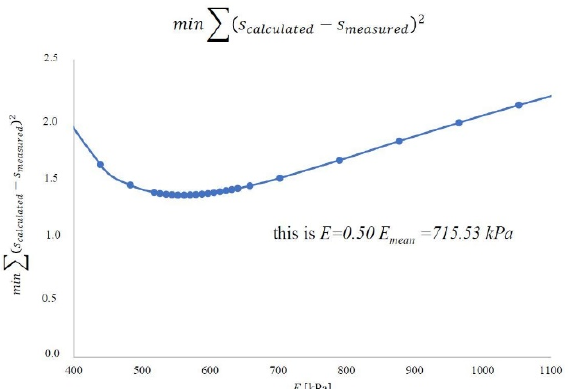
Figure 24. The representative value of the constrained modulus of elasticity of the peat material on the Ostrów Brdowski island in Szczecin according to the oedometer test.